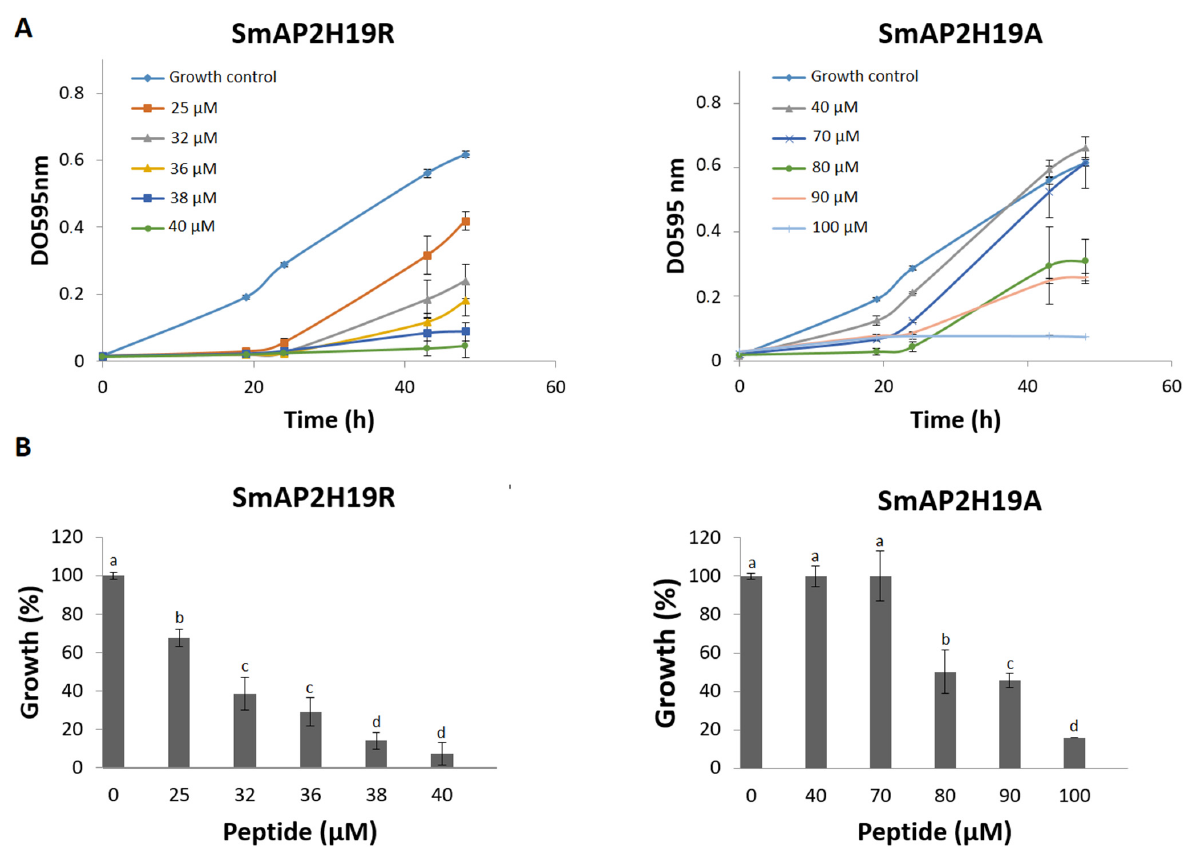
Figure 1. ( A ) Growth curves of Fusarium graminearum in the presence of different concentrations of SmAP α 1-21 -derived peptides. Error bars represent standard deviation of technical triplicates. DO 595 nm is optical density at 595 nm. ( B ) Percentage of growth of F. graminearum at final time point in panel A (48 h). Bars represent mean ± standard deviation of percentage of growth as compared with 100% from control growth, defined as fungus growth in absence of peptide. Treatments with same letter do not significantly differ ( p > 0.05).